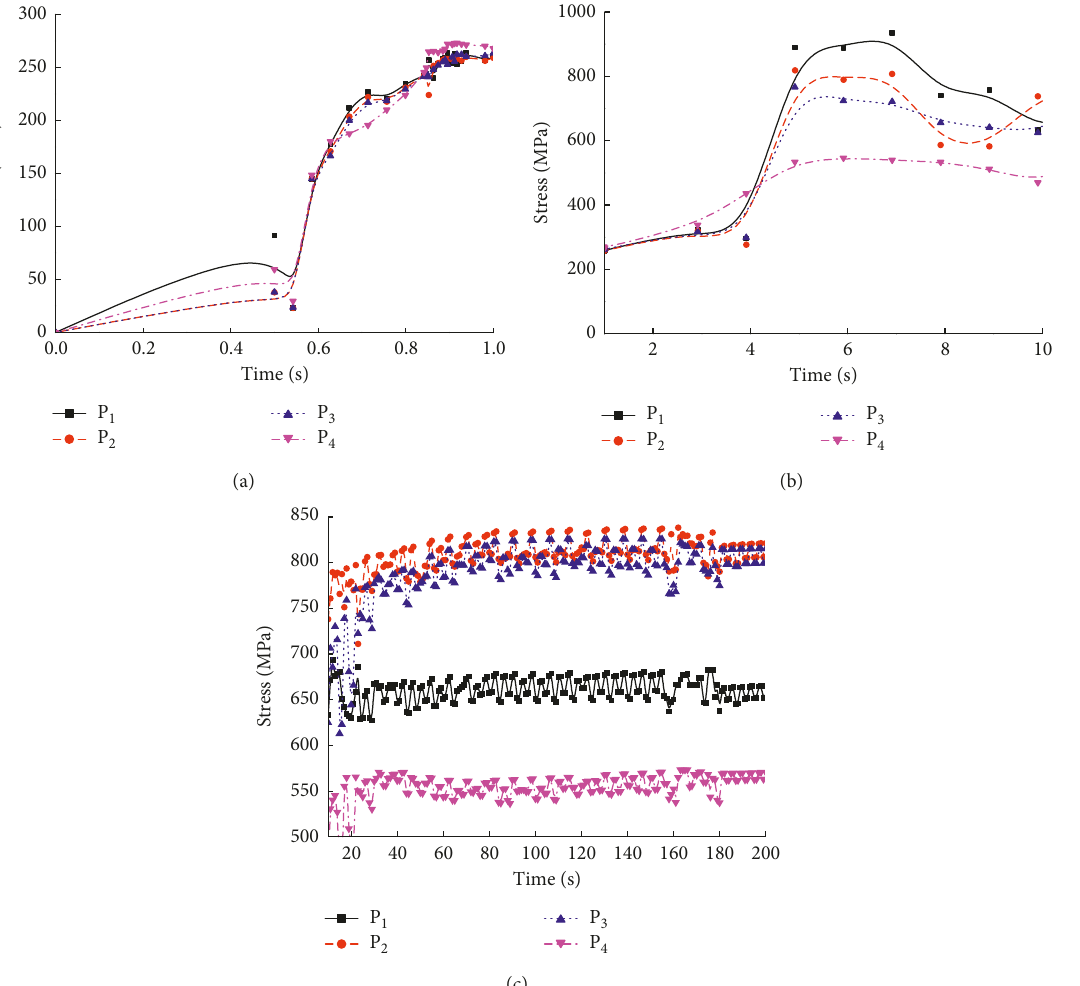
Figure 8: The residual stresses at the trace points at different times (1 st welding condition): (a) 0–1s; (b) 1–10s; (c)